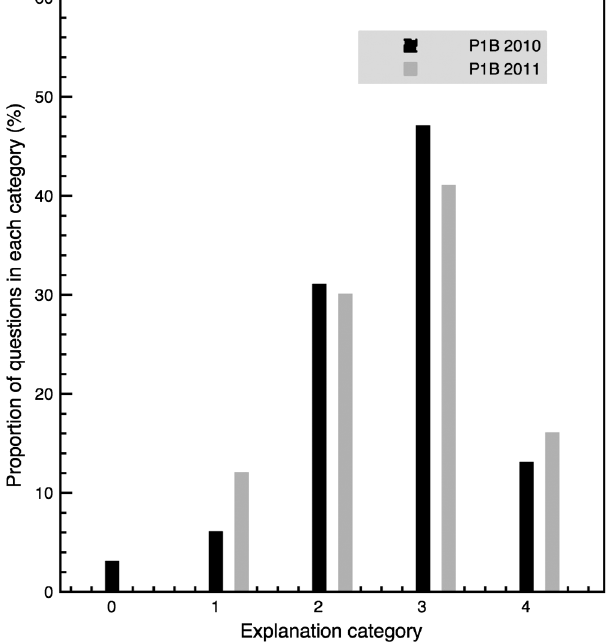
FIG. 3. Proportion of questions in each explanation category, for Physics 1A question repositories for 2010 ( N ¼ 150 , dark bars) and 2011 ( N ¼ 200 , light bars).